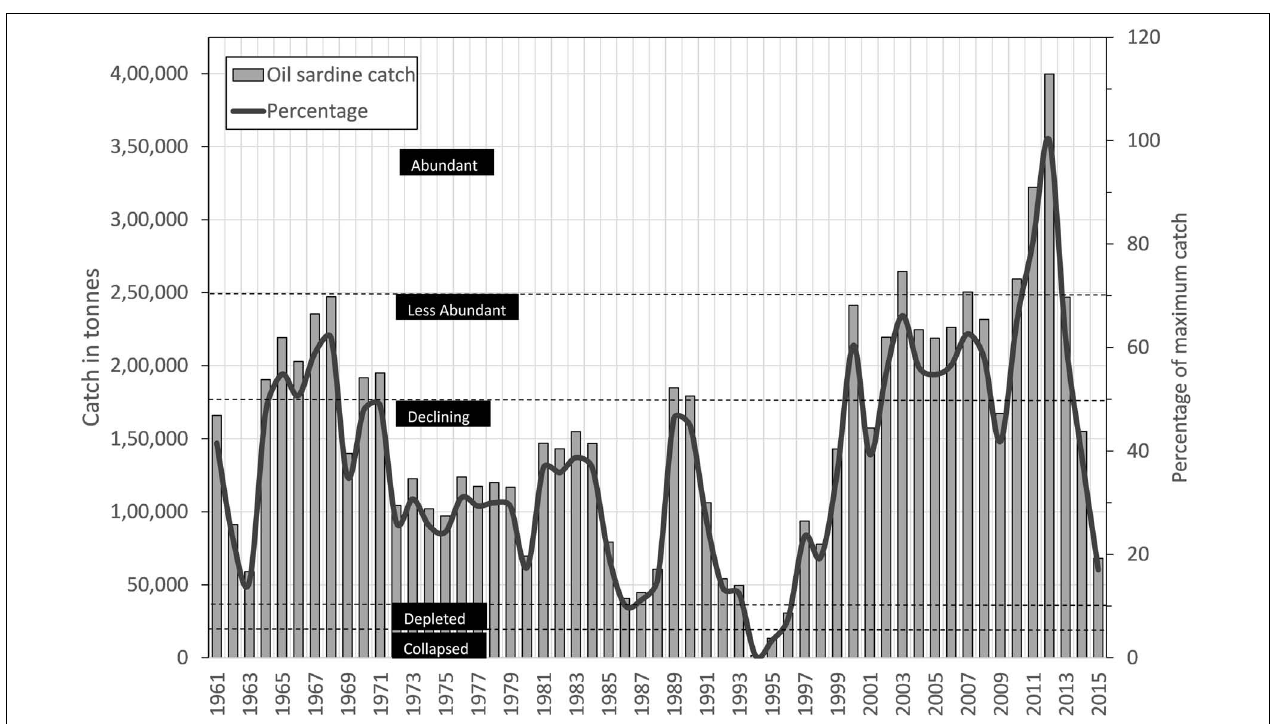
FIGURE 2 | Time series of estimated oil sardine catch (bars) from Kerala State with percentage of historical maximum (line) and classification of stock-status based on the percentage.